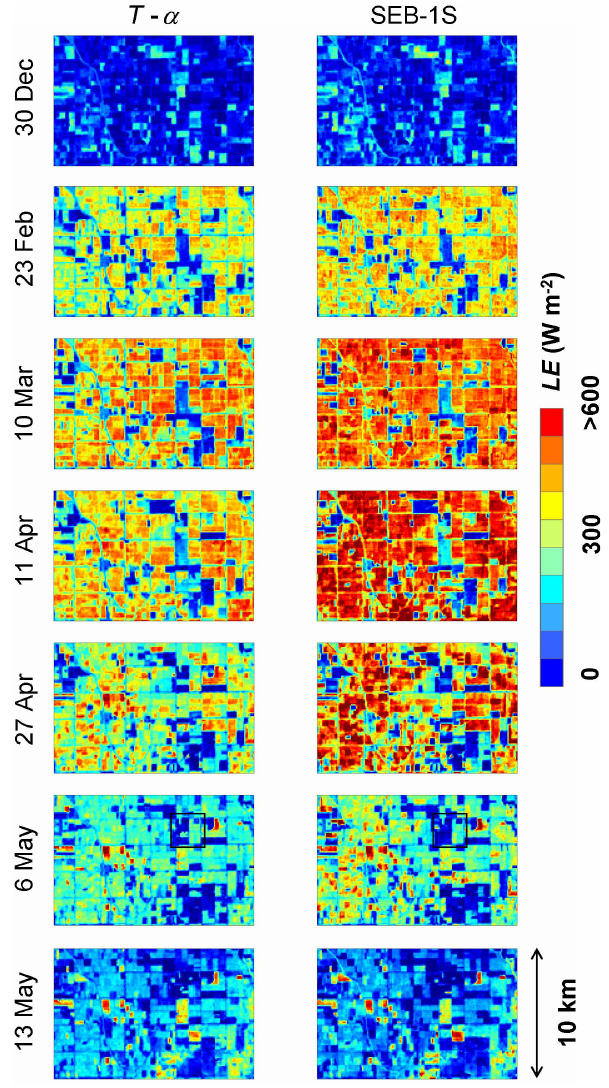
Fig. 9. Images on the seven ASTER overpass dates of the ET sim- ulated by the classical T − α space-based model and SEB-1S. The enclosed sub-area for data on 6 May 2008 is enlarged in Fig.